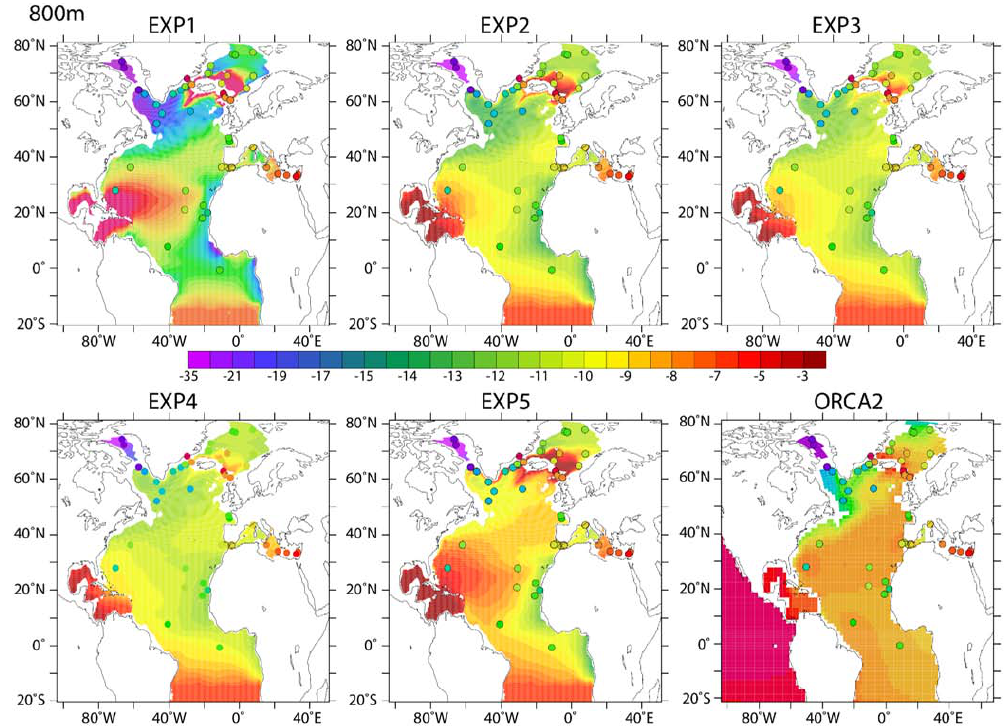
Fig. 3. Same as Fig. 2, but at 800m depth. Data plotted (circles) are from 500 to 1000m depth. Data are issued from Piepgras and Wasserburg (1980, 1983, 1987), Stordal and Wasserburg (1986), Spivack and Wasserburg (1988), Tachikawa et al. (1999), Lacan and Jeandel (2004a,b,c, 2005a,b), Dahlqvist and Andersoon (2005) and Rickli et al. (2009) and compiled by F. Lacan and K. Tachikawa (available here: http://www.legos.obs-mip.fr/fr/equipes/geomar/results/database